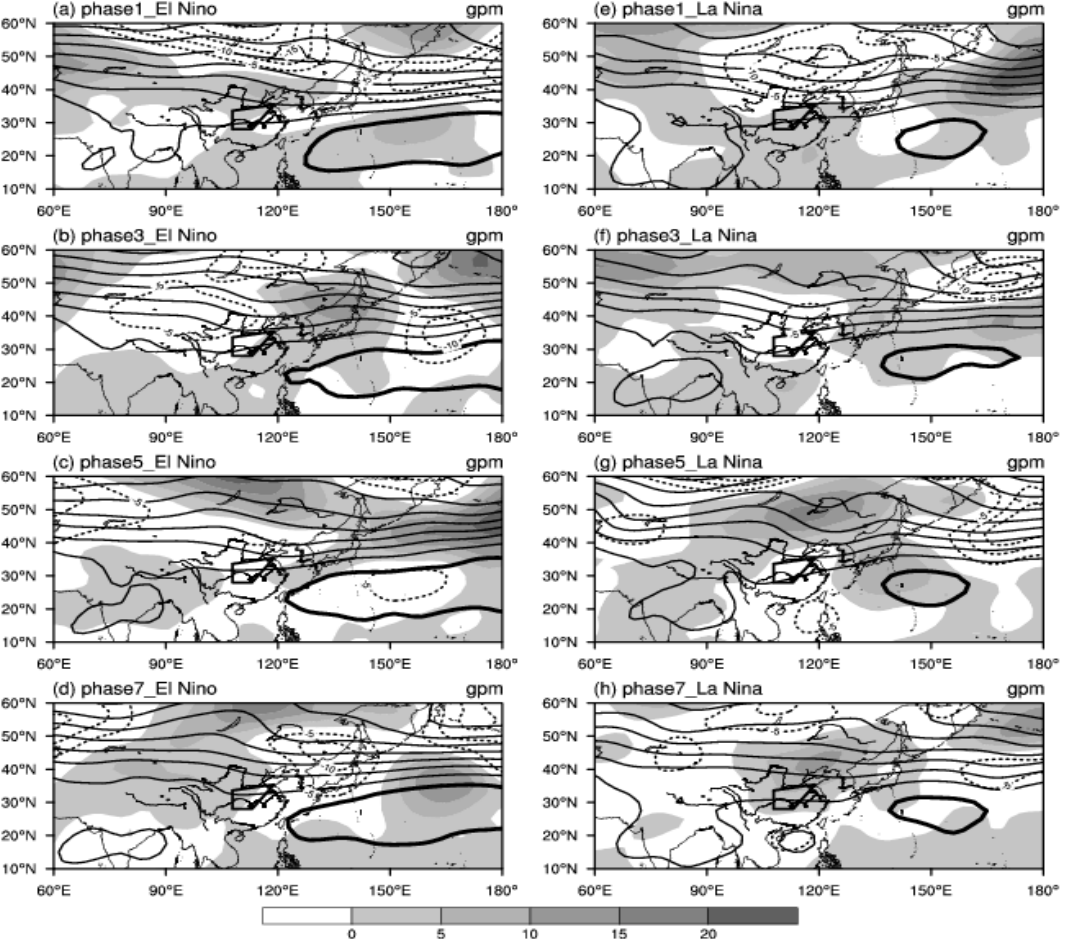
Figure 7. Same as Figure 5, but for the phase synthesis of 10–20 d low-frequency height fields and the unfiltered height fields at 500 hPa (unit: gpm), black thick solid line denotes unfiltered 5880 gpm contour.